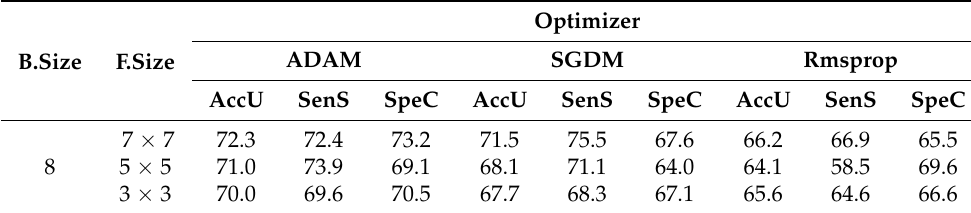
Table A3. Classification performance of 3L-CNN using SFC images. The CNNs are evaluated based on the accuracy, sensitivity and specificity of 10-fold CV at different convolutional filter sizes (F.size), batch sizes (B.size) and optimization algorithms. Accordingly, the CNN achieved high scores based on F.size 7 × 7, B.size = 8 and ADAM